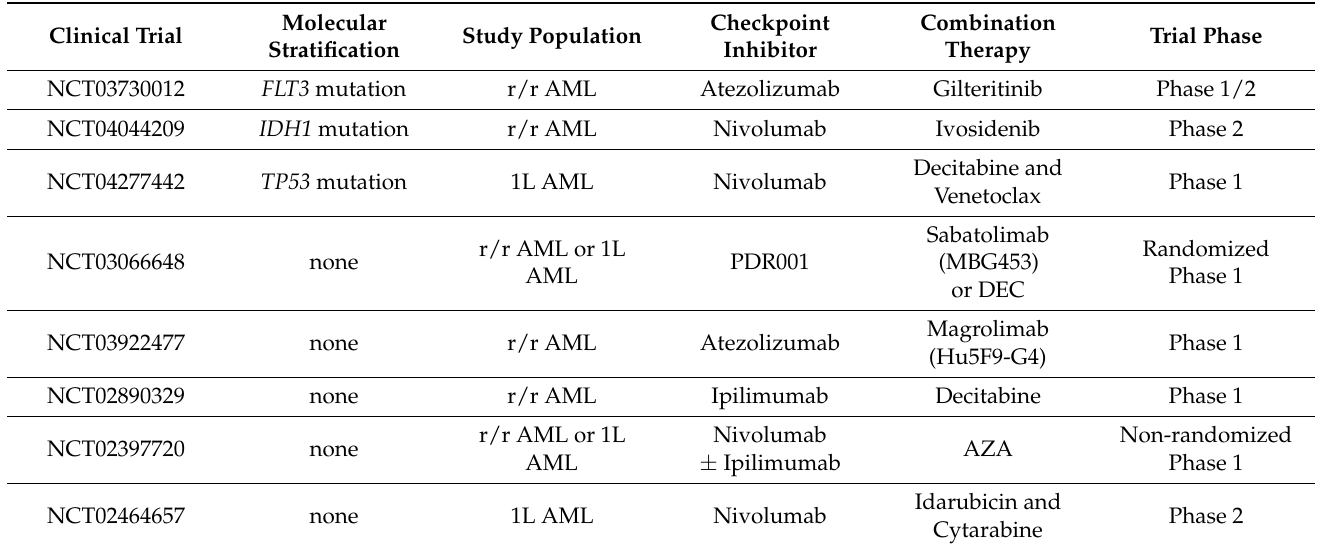
Table 3. Selection of ongoing clinical trials in AML with checkpoint